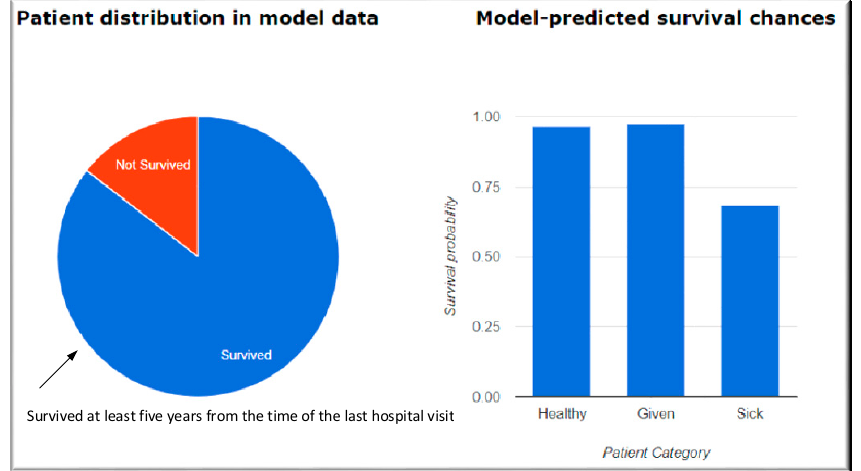
Figure 3. Results of the Questionnaires. Healthy patient—Median model-predicted probability of 5-year survival of patients who actually survived 5 years. Given patient—This corresponds to the chances of survival of a patient for at least 5 years, calculated based on the provided values of the patient attributes. Sick patient—Median model-predicted probability of 5-year survival of patients who did not survive the 5 years (Reproduced with permission from Ankit Agrawal [18]).